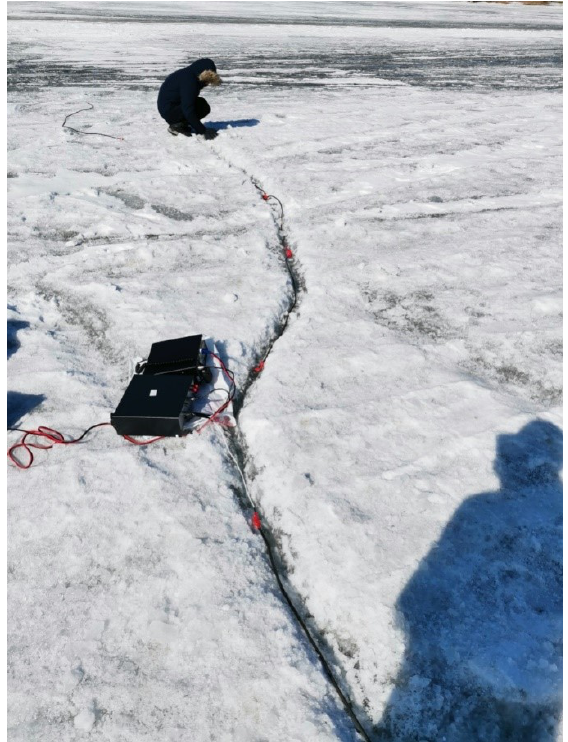
Fig.7. Laying of antenna into the